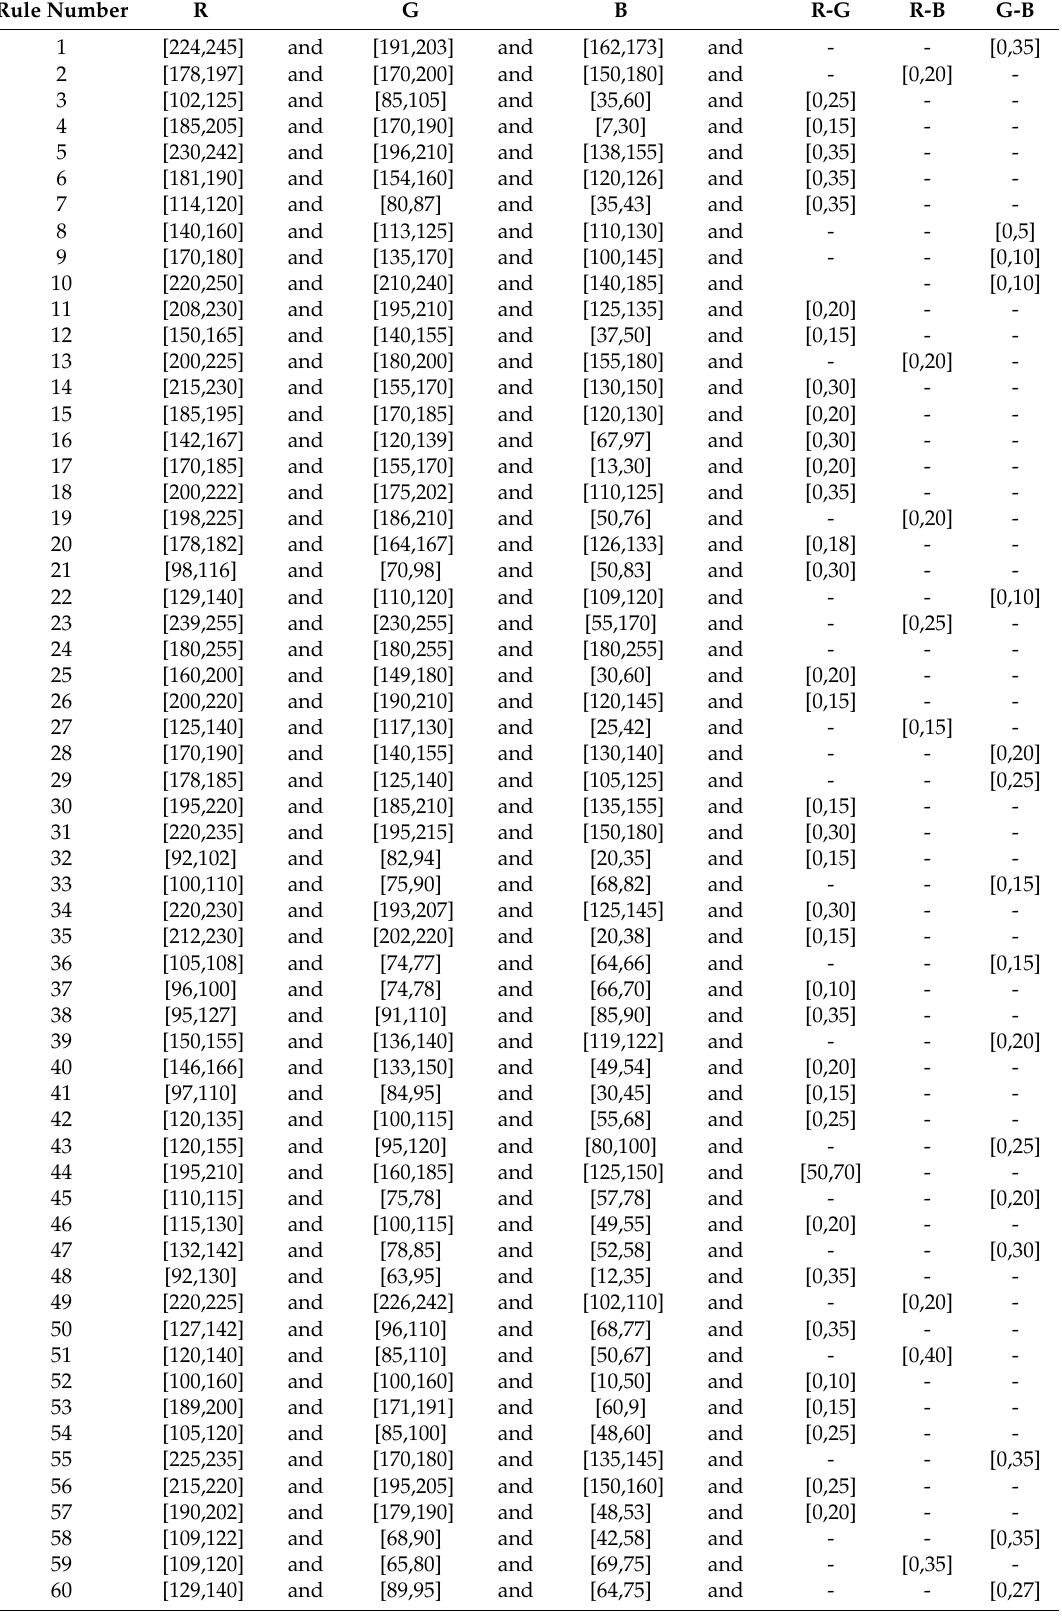
Table 6. Thresholds defined in RGB color space for the segmentation of background